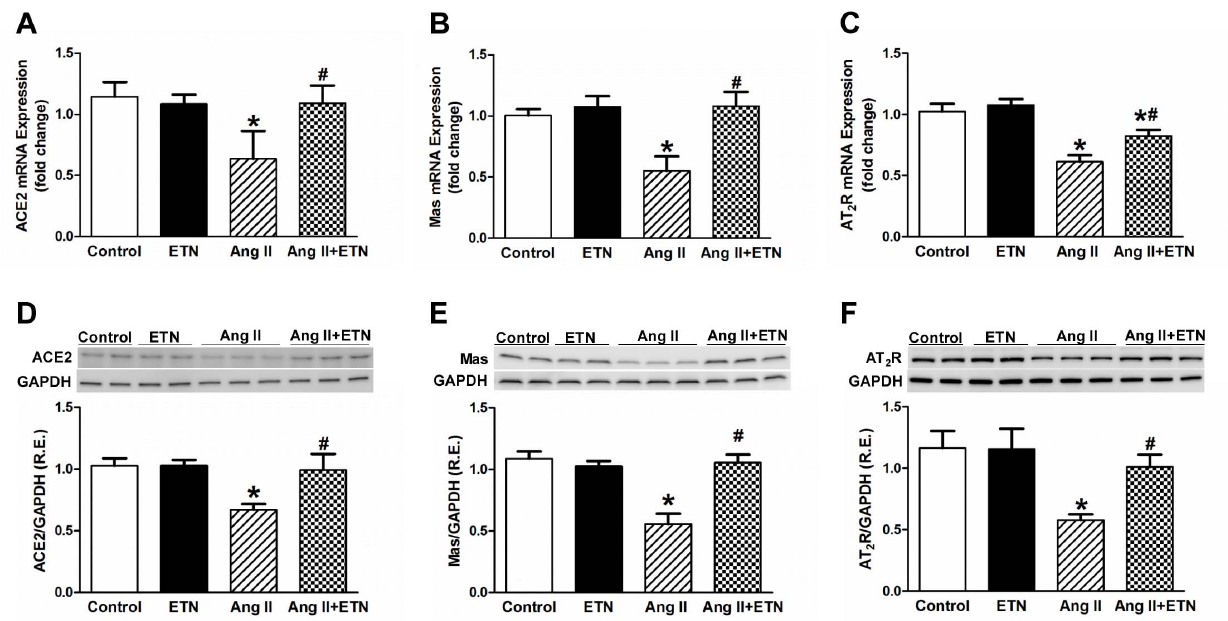
Figure 4. Effect of central TNF blockade on anti-hypertensive RAS component expression in the PVN. Chronic 28-day Ang II infusion decreased the mRNA and protein expression of anti-hypertensive RAS components, ACE2, the Mas receptor, and AT 2 receptors in the PVN. This decrease was prevented by central TNF blockade using etanercept. R.E. Relative expression, n=8–12 per group, * p , 0.05 vs Control, # p , 0.05 vs Ang II.